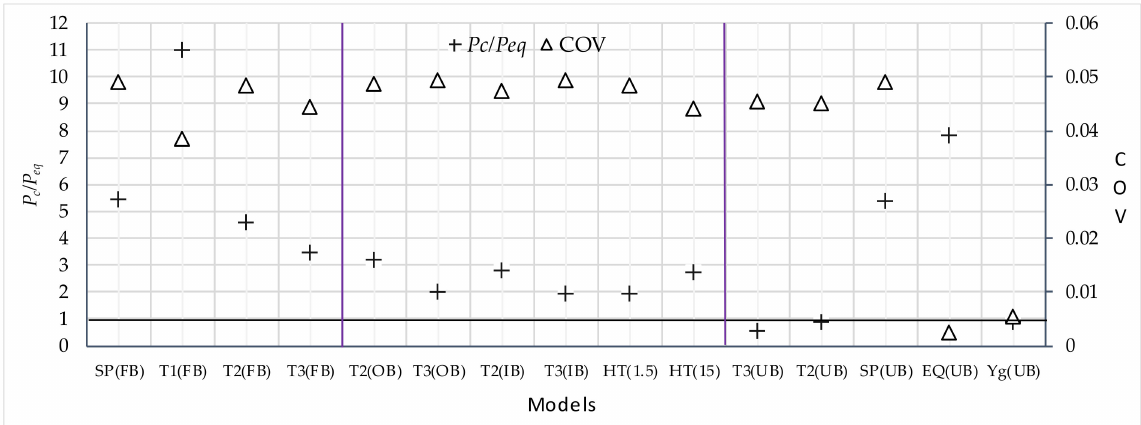
Figure 8. COV and P c / P eq for SP collapse strength models.